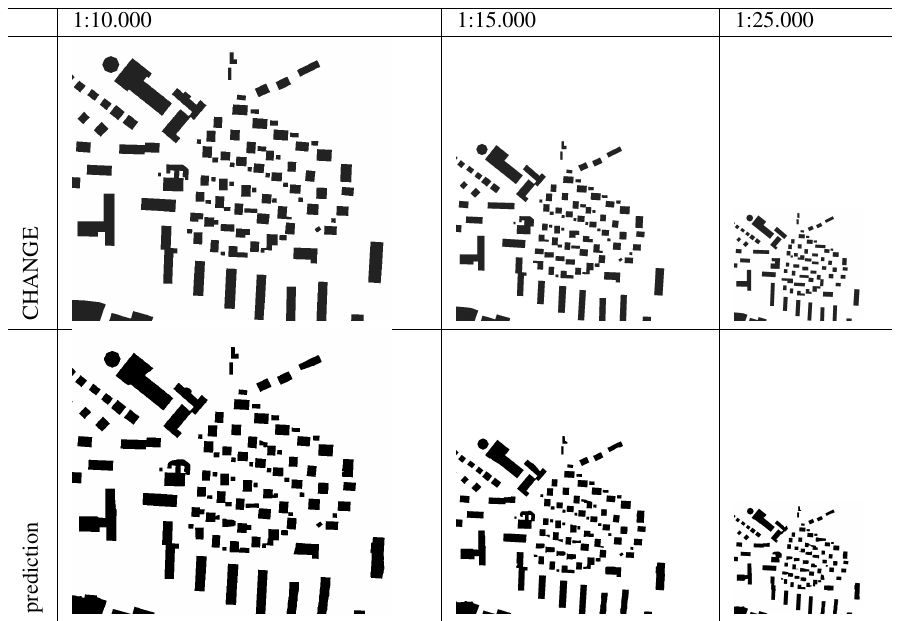
Figure 11. comparison of target scales (top) and predicted presentations (bottom).